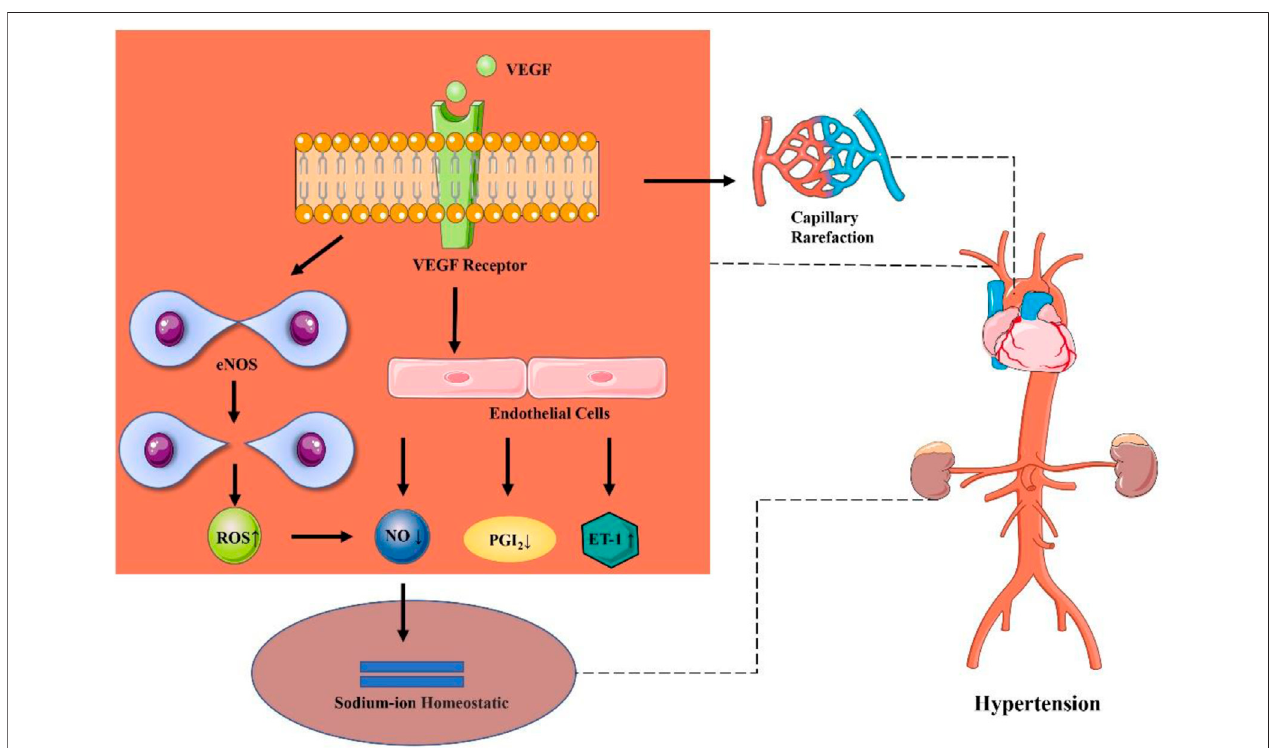
FIGURE 10 | Possible mechanism of hypertension caused by cancer